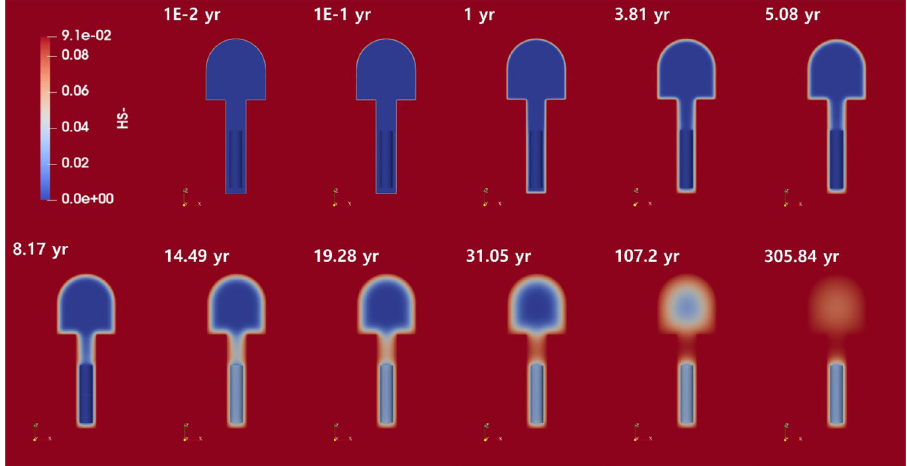
Fig. 12 Concentration pro fi le of HS − . Distributions of HS − in engineering barrier system (disposal turner, bentonite, and